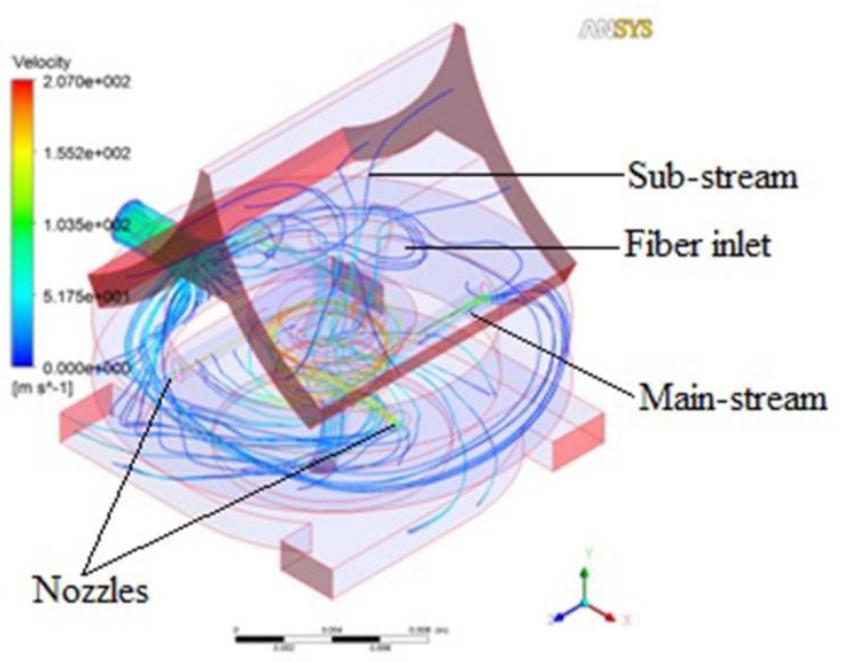
Figure 4. Airflow trace in the pre-twister.